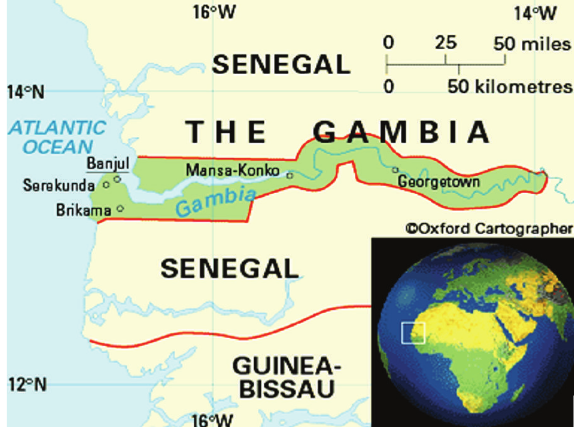
Figure 1: Map and location of Gambia [8].